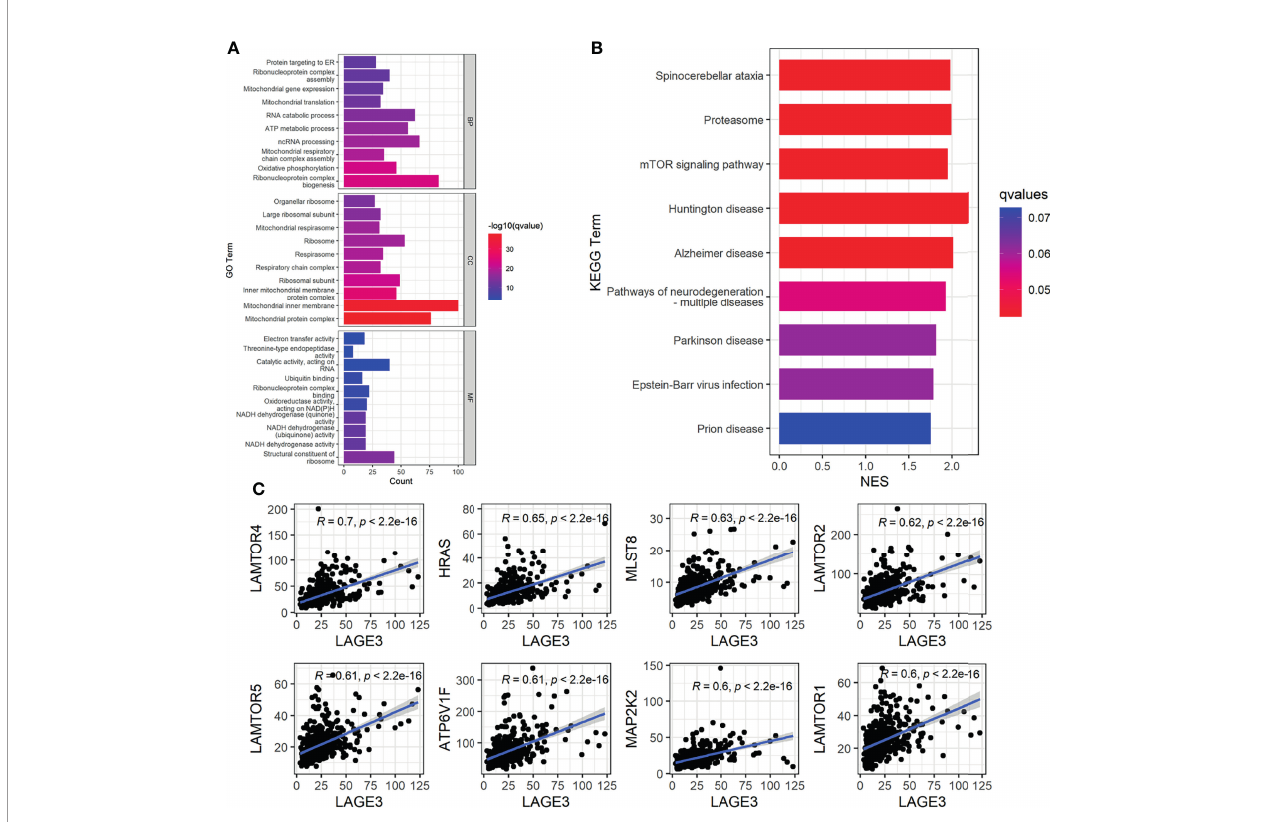
FIGURE 5 | The potential functions and pathways of LAGE3 in HCC. (A) Top 10 terms of each subtype of GO enrichment analysis by genes co-expressed with LAGE3 in HCC. (B) GSEA-KEGG enrichment analysis by genes co-expressed with LAGE3 in HCC. (C) The top 8 genes which were strong correlated with LAGE3 expression enriched in mTOR signaling